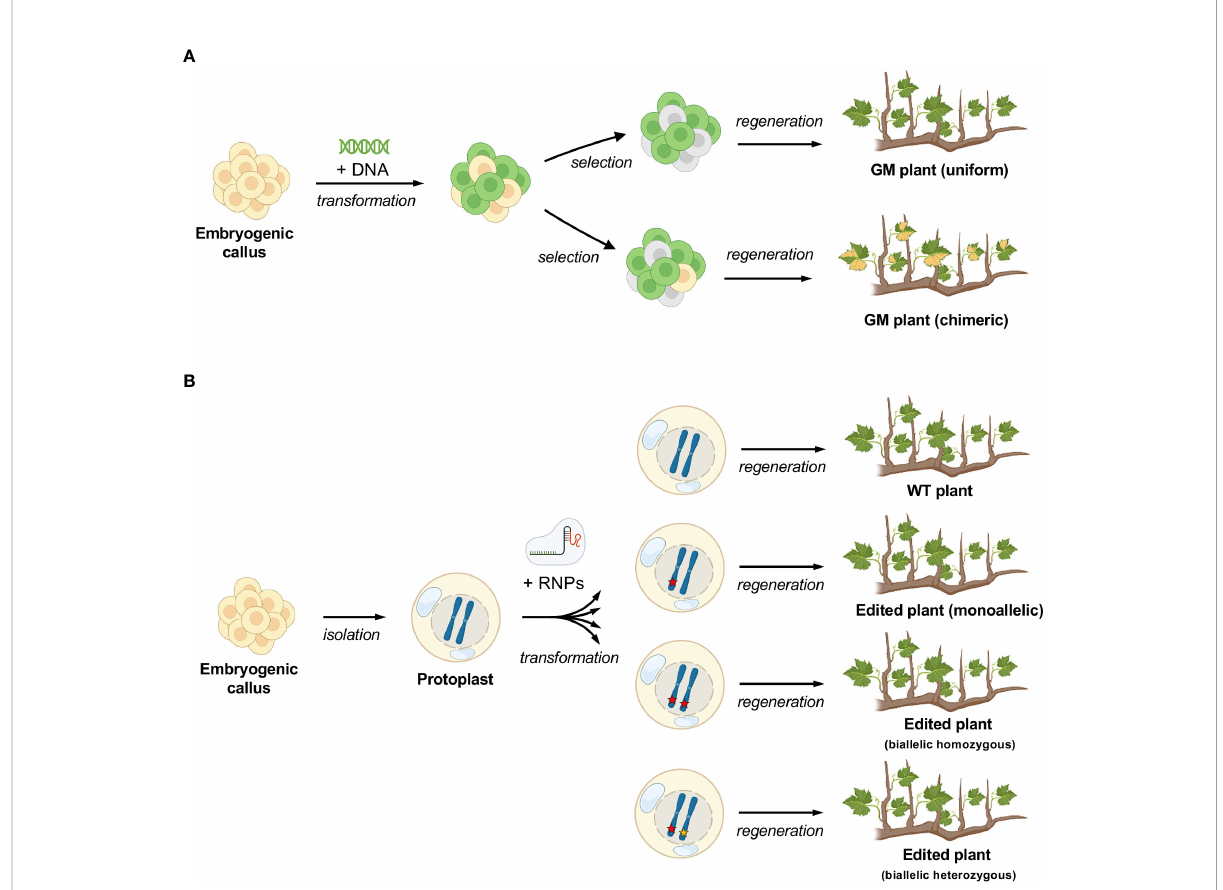
FIGURE 5 Differences in the process of regeneration of grapevine plants between callus and protoplasts. (A) standard process with exogenous DNA insertion and possibility of chimerism (depicted here by variegated leaves) (B) protoplast regeneration, where there is no possibility for chimerism. The different editing outcomes are simulated (editing events are depicted by red and yellow